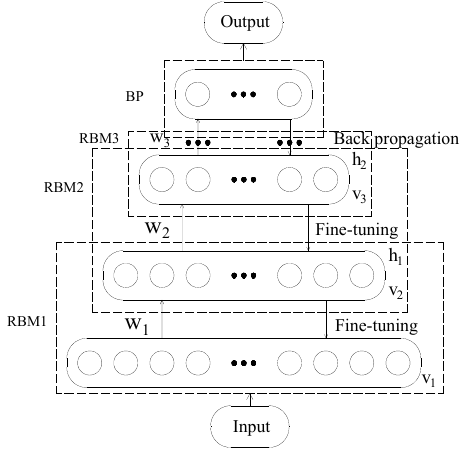
Figure 2. Deep belief network structure.